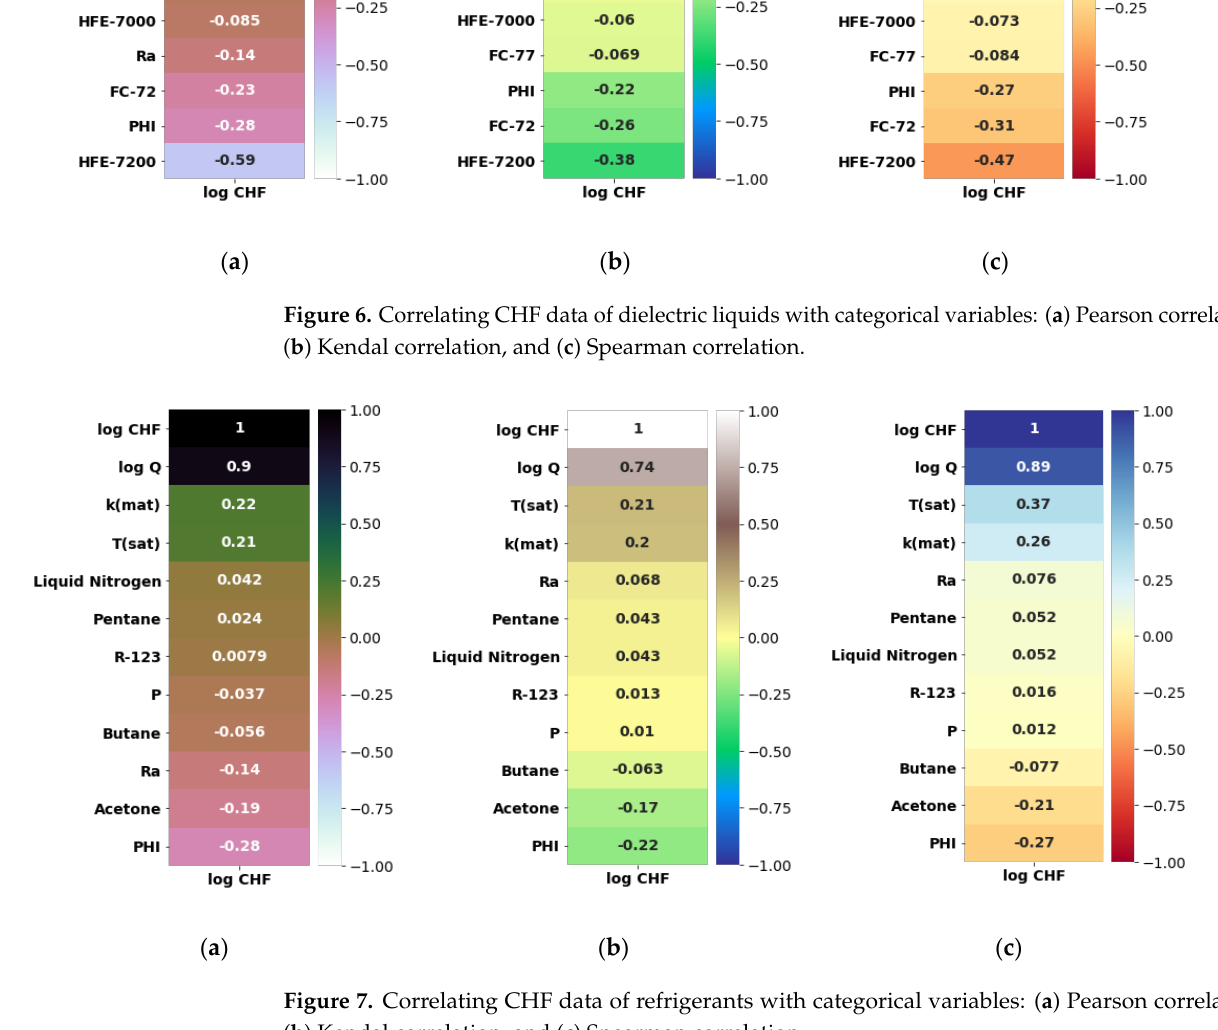
Figure 7. Correlating CHF data of refrigerants with categorical variables: ( a ) Pearson correlation, ( b ) Kendal correlation, and ( c ) Spearman correlation.